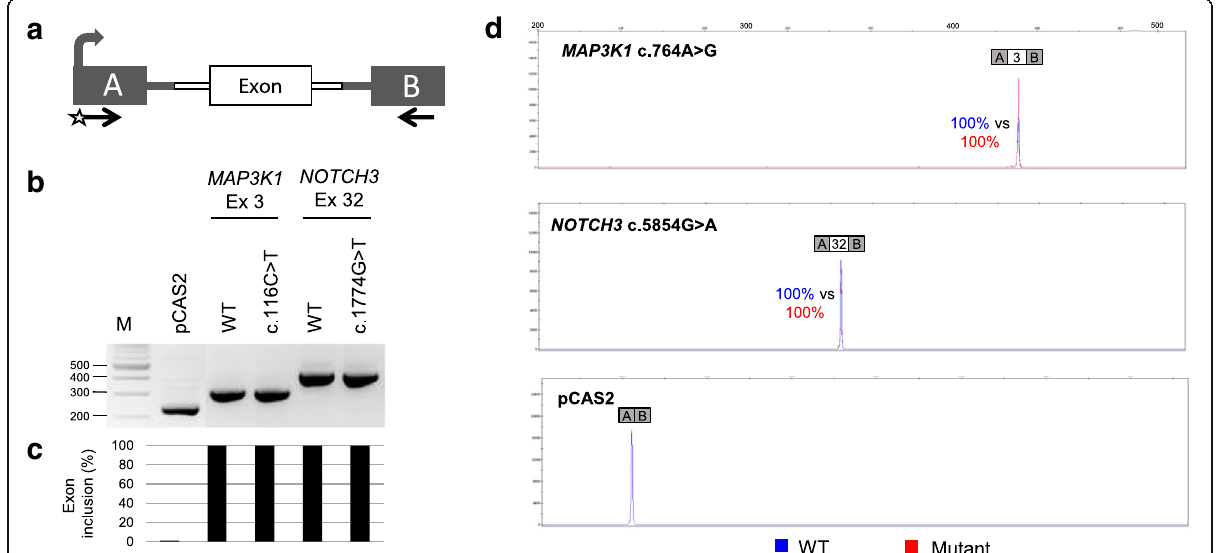
Fig. 1 Evaluation of variant-induced splicing alterations by using a cell-based minigene assay. a Structure of pCAS2 minigenes used in the splicing reporter assay. The bent arrow indicates the CMV promoter, boxes represent exons, lines in between the boxes indicate introns, and arrows below the exons represent primers used in RT-PCR reactions. The minigenes were generated by inserting a genomic fragment containing the exon of interest together with its flanking intronic sequences into the intron of pCAS2, as described under Materials and Methods. b Analysis of the splicing pattern of pCAS2 minigenes carrying variants identified in this study. Wild-type (WT) and mutant constructs, as indicated, were introduced into HeLa cells and the transcripts of the minigenes were analyzed by RT-PCR 24 h post-transfection. The image shows the results of a representative experiment in which the RT-PCR products were separated on a 2.5% agarose gel stained with EtBr and visualized by exposure to ultraviolet light. M, 100 bp DNA ladder (New England Biolabs). c Quantification of splicing events observed in the minigene splicing assay. The relative levels of exon inclusion indicated under the gel are based on RT- PCR experiments equivalent to those shown in B but performed with a fluorescent forward primer and then separated on an automated sequencer. Quantification results were obtained by using the GeneMapper v5.0 software (Applied Biosystems) and correspond to the average of two independent fluorescent-RT-PCR experiments. d Representative fluorescent RT-PCR experiment. The panel shows superposed peaks corresponding to the WT and mutant products (in blue and red, respectively), as